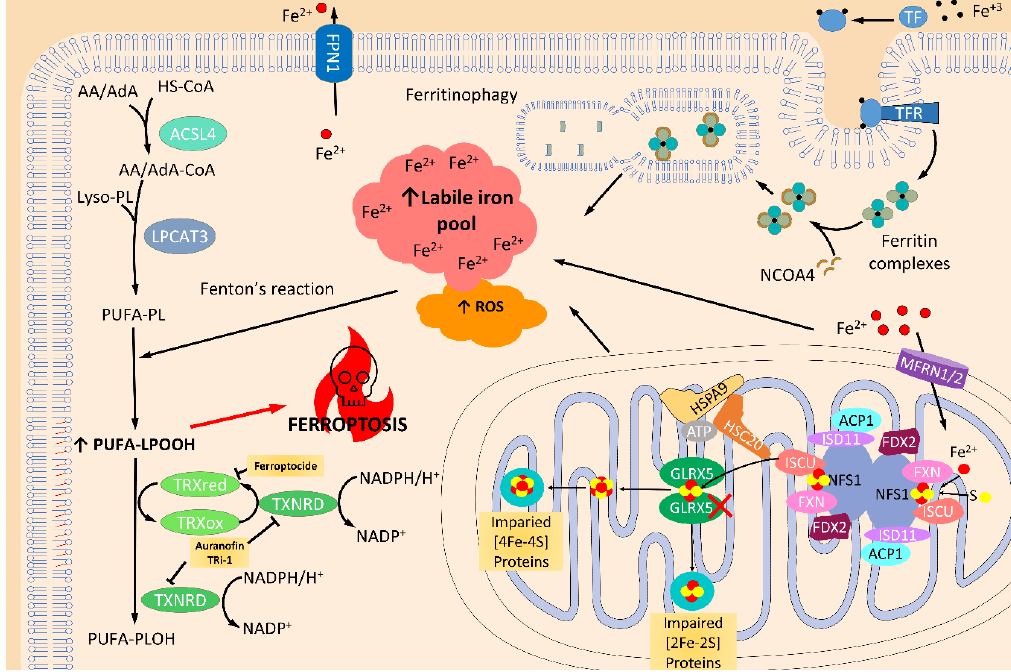
Figure 4. Ferroptosis activation by the inhibition of the thioredoxin and glutaredoxin